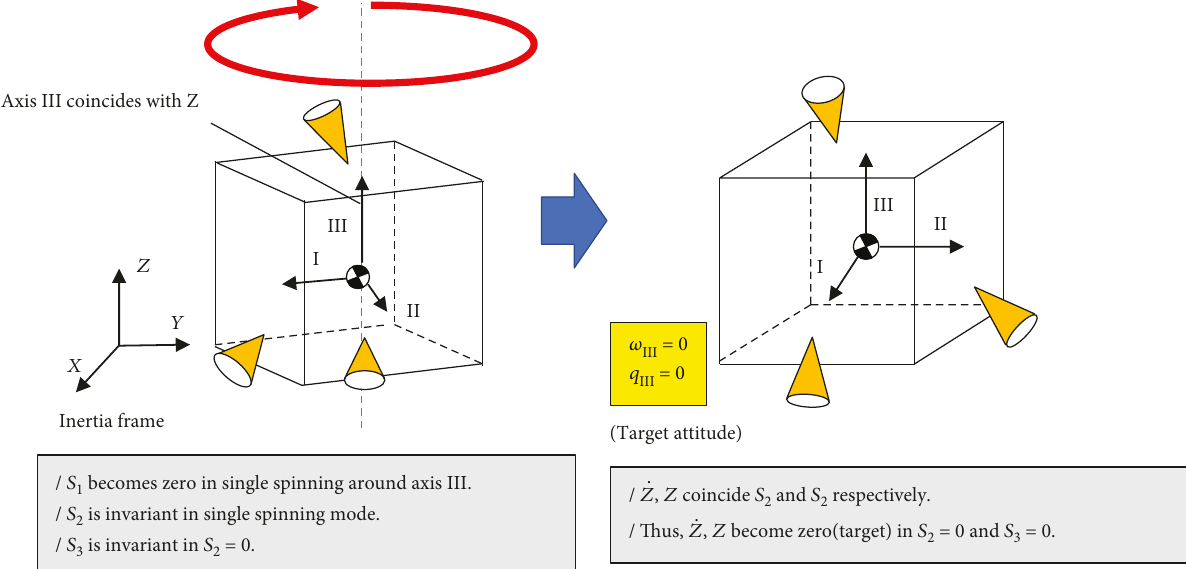
Figure 2: Schematic image of the S